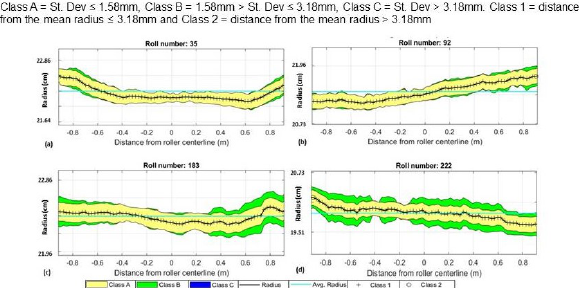
Figure 14. Radius calculated using every slice of the roller.